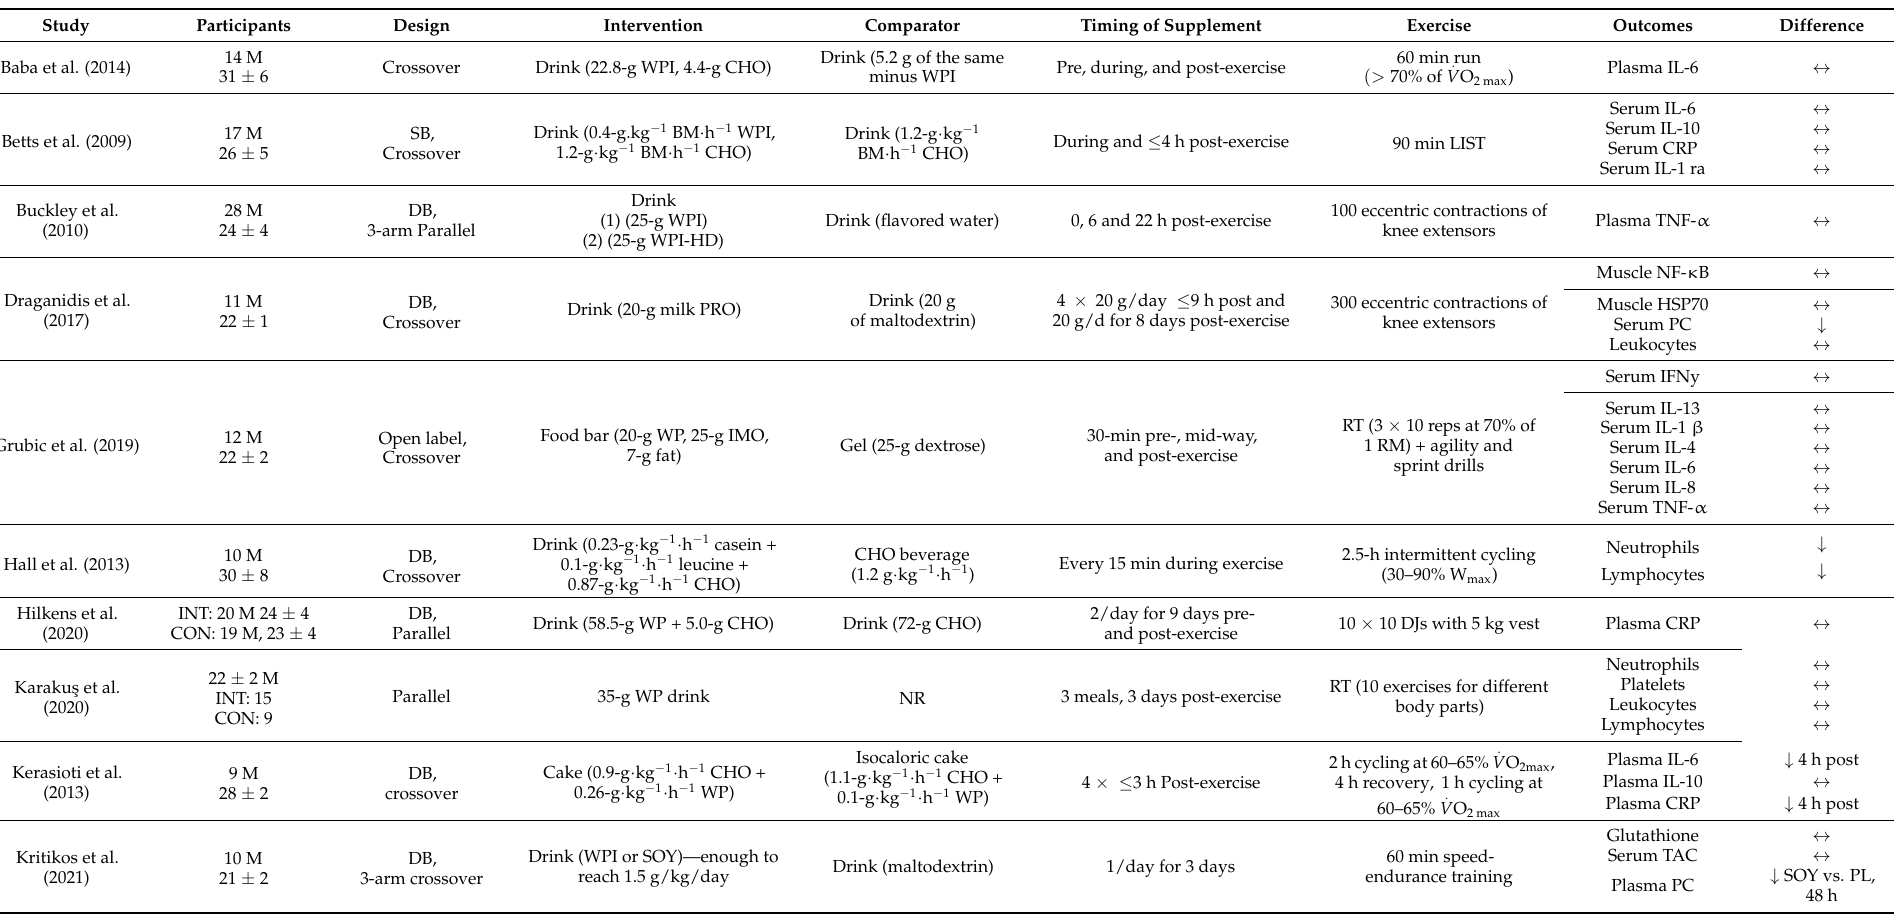
Table 1. Studies examining the effects of whole protein supplementation on markers of exercise-induced inflammation and oxidative stress. The Difference column denotes intervention vs.